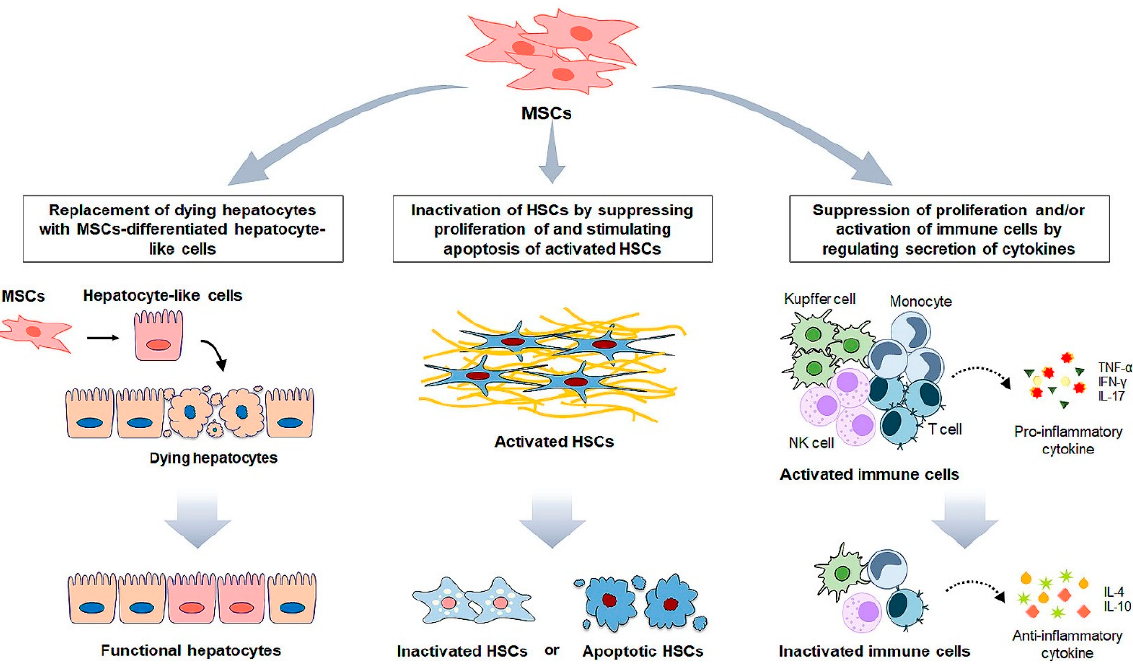
Figure 2. MSC-based therapeutic approaches in liver fibrosis. Administration of mesenchymal stem cells (MSCs) exerts therapeutic effects for the liver fibrosis through various mechanisms. MSCs can replace dying hepatocytes by differentiate into hepatocyte-like cells. MSC-derived hepatocyte-like cells express hepatocyte markers, and show hepatocytic functions including glycogen synthesis, albumin secretion, low-density lipoprotein (LDL) uptake, urea production and drug metabolism. MSCs inhibit HSC activation by suppressing proliferation of and stimulating apoptosis of activated HSCs. MSCs upregulate the inhibitors of cell proliferation and downregulates the accelerators of cell cycle. Increased proapoptotic proteins by MSCs also reduce viability of activated HSCs viability. In addition, MSCs alleviate immune responses by interacting immune cells. MSCs exert anti-inflammatory properties by suppressing the synthesis of pro-inflammatory cytokines such as tumor necrosis factor (TNF)- α , interferon (IFN)- γ , and IL-17, and promoting production of anti-inflammatory cytokines, IL-4 and IL-10, in immune cells such as T cell, natural killer (NK) cells, neutrophils and Kupffer cells. In addition, MSCs significantly reduce proliferation and/or activation of immune cells to suppress immune response.